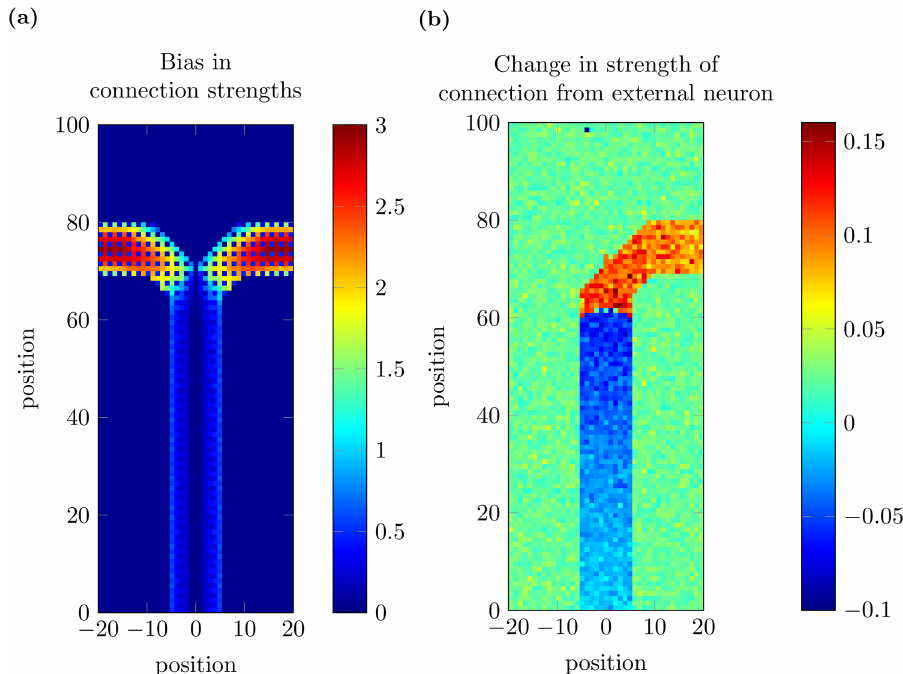
Fig 5. Changes to connection strengths after 20 training trials in the spiking neural circuit model. Coordinates of the x-axis are centeredon the center stem to more clearly show the level of symmetry present in connectionstrength changes.We note that after 20 trials, these values are quite stable. (a) The bias (calculated using Eq 27) in connections from neuronsin the center stem to other neuronsin the 2D spiking neuralcircuit is small. For neuronson the two arms, the values are close to the theoretical maximum value, slightly larger than 3. (b) Changesto couplingstrength from the external cue neuronare not symmetric. The averagechange in couplingstrength for connections from the externalcue neuron, C 2 in this case, shows a clear bias towards the right hand side of the